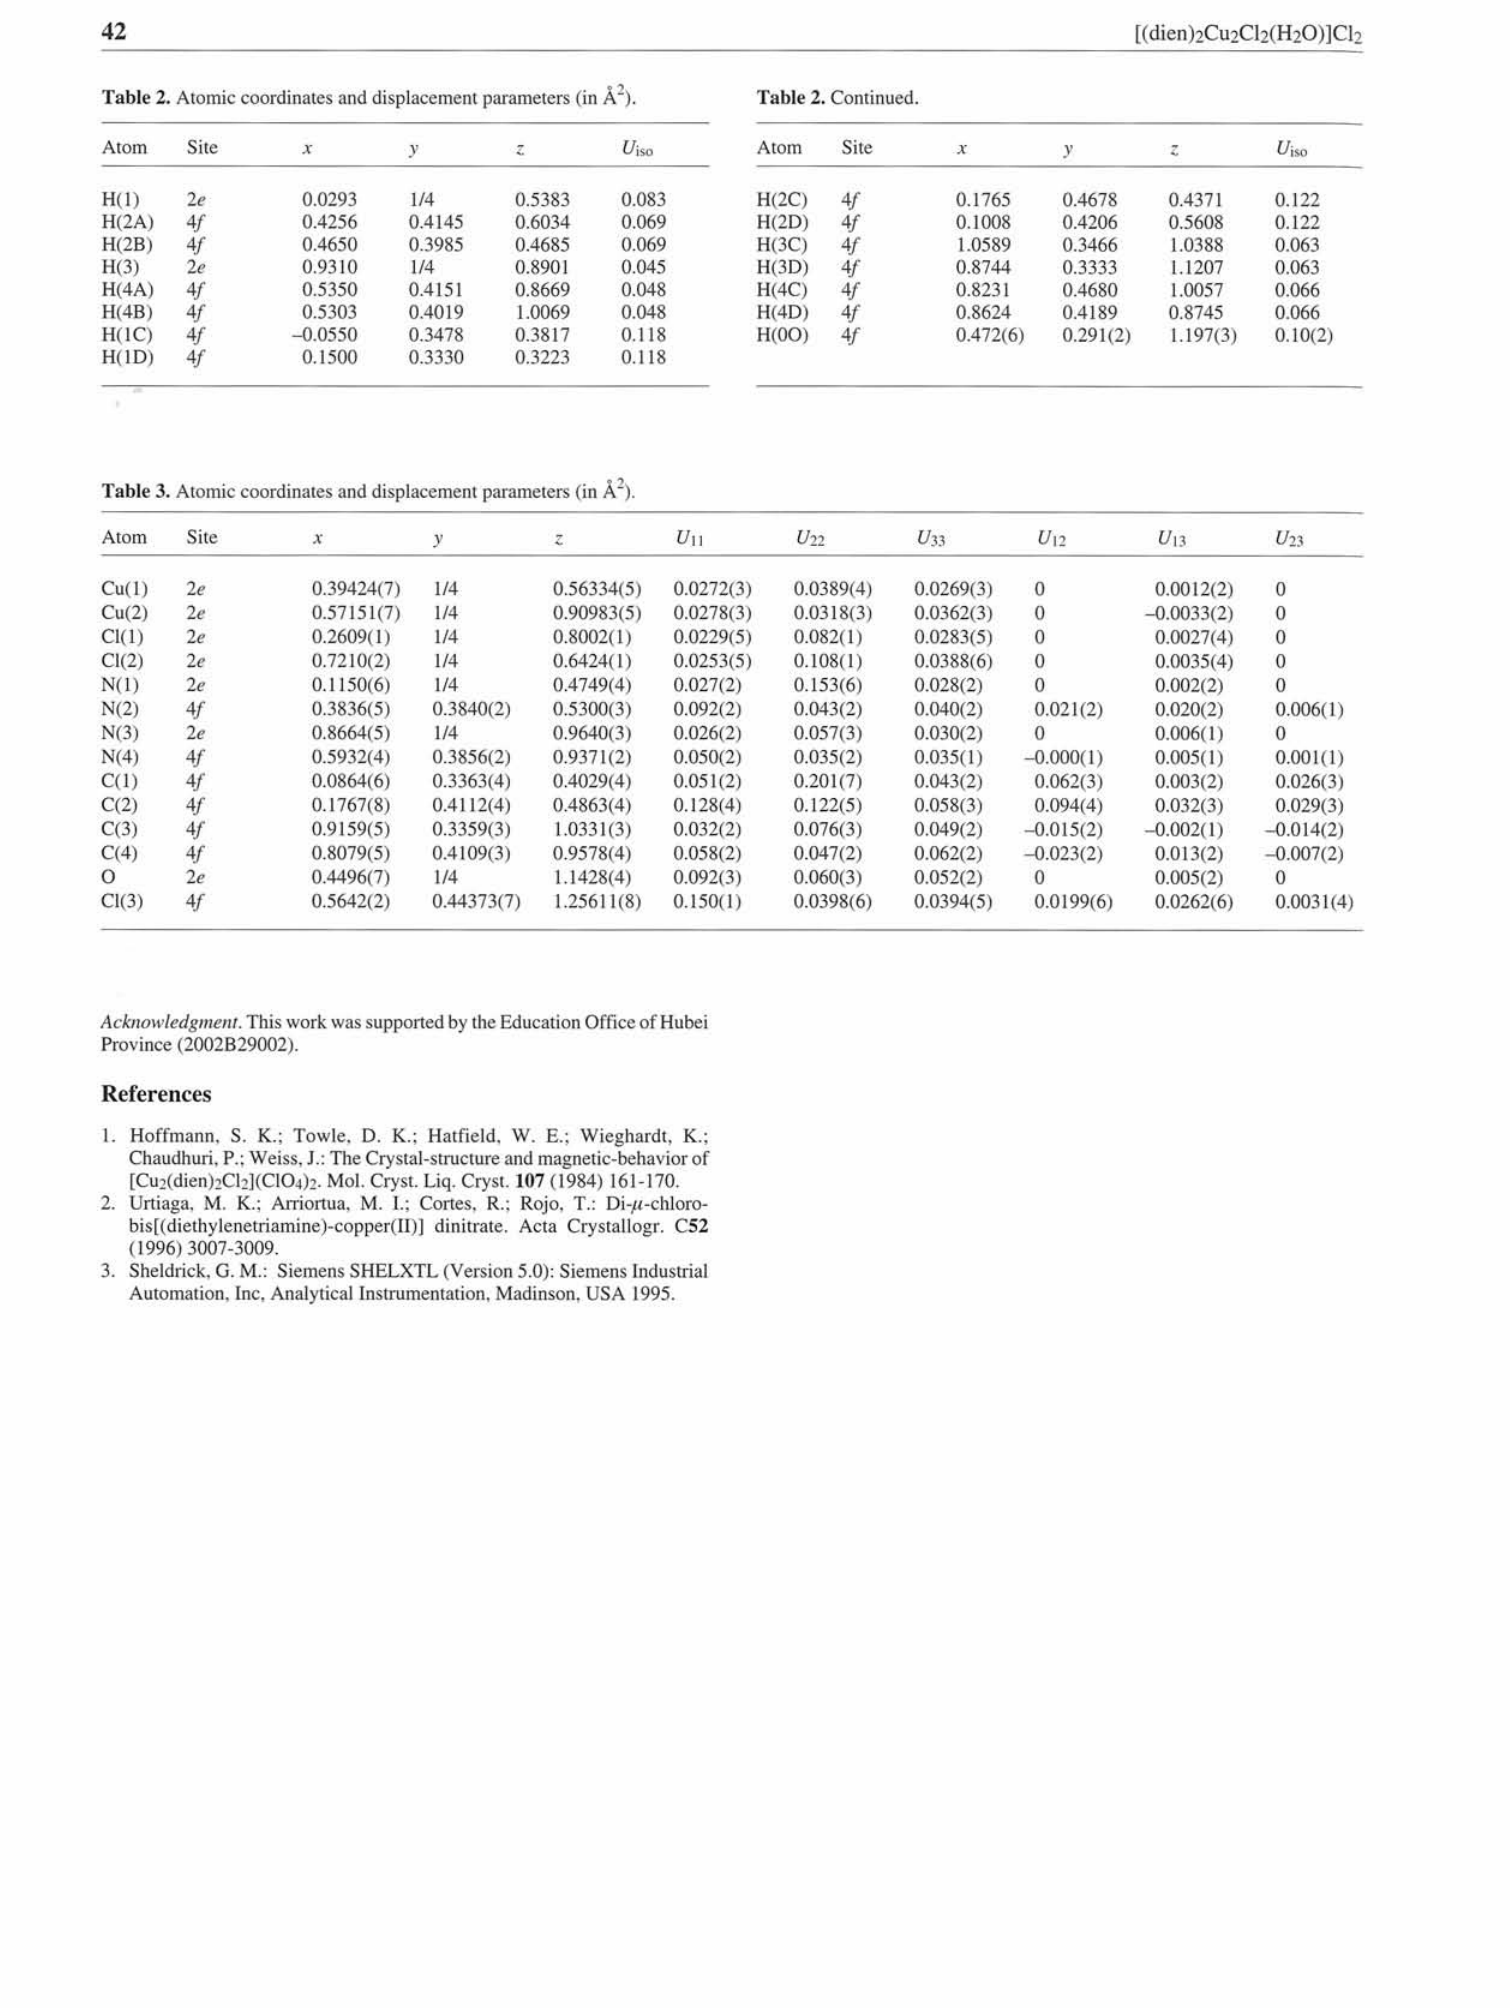
Table 2. Atomic coordinates and displacement parameters (in A").